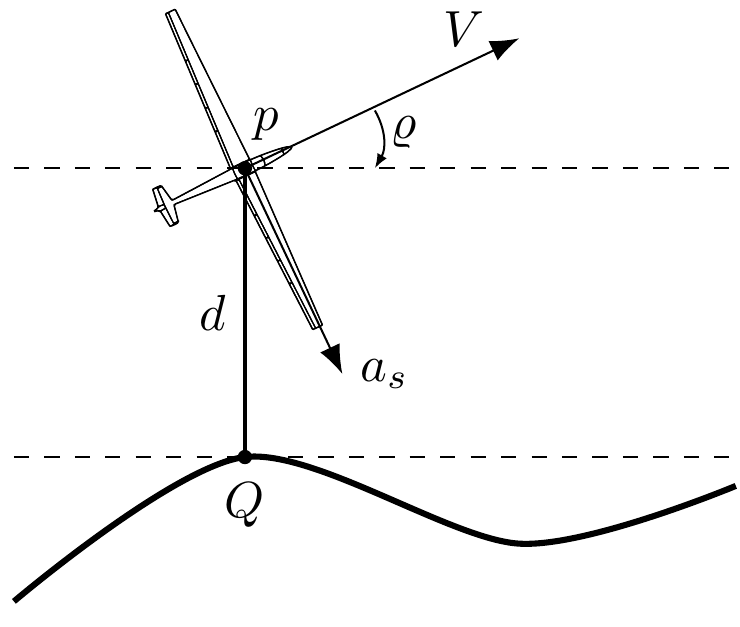
Figure 3. Path-following model coordinates ( d , (cid:36) )